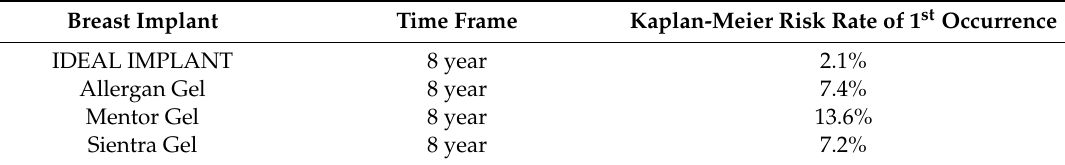
Table 1. Deflation / Rupture (MRI Cohort). FDA trial data for primary augmentation. Breast Implant